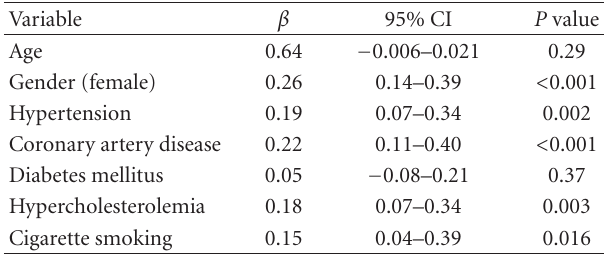
Table 4: Multiple linear regression analysis with hs-CRP as the de- pendent